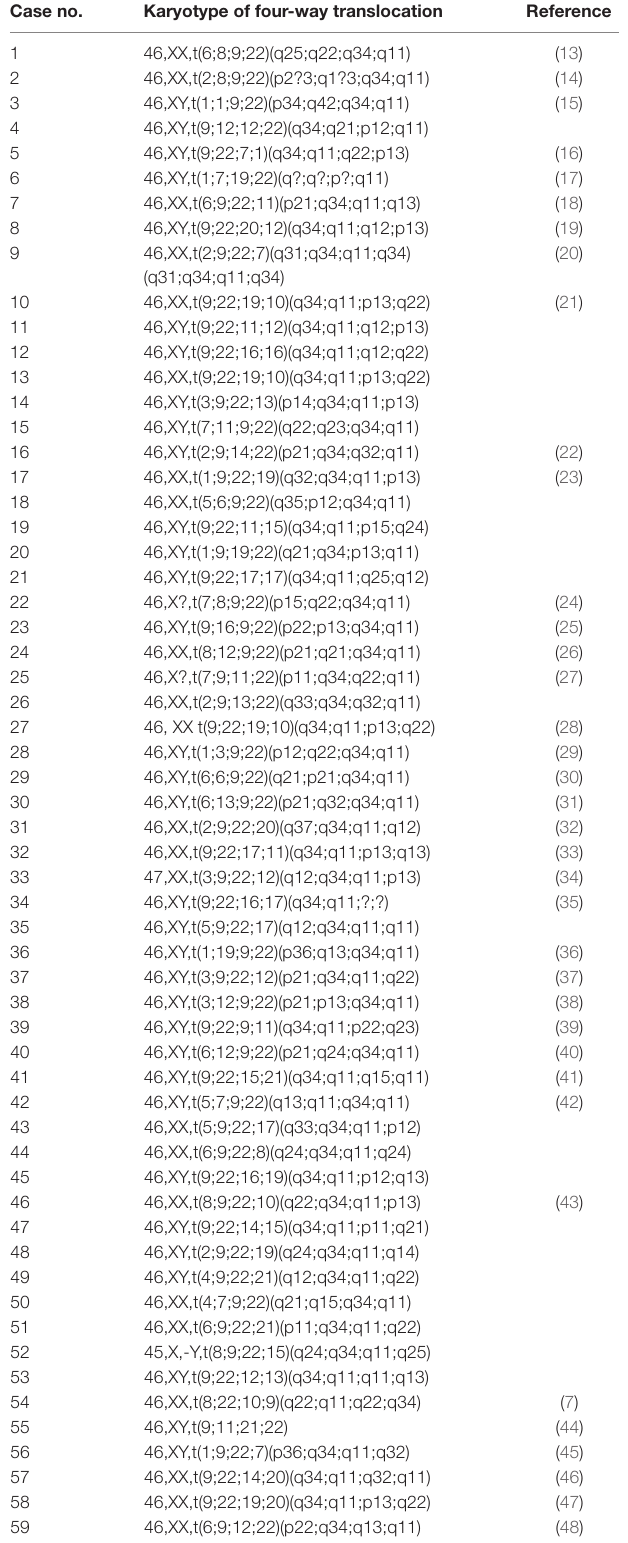
taBLe 1 | Number of complex variant four-way ph chromosome translocations reported in the literature.